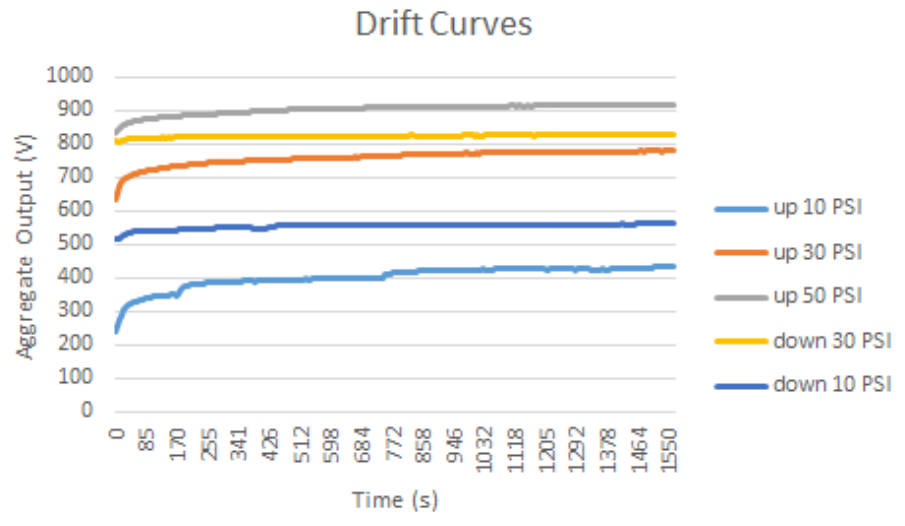
Figure 4. Drift of the Aggregate Output registered by the PCB based sensor for different increments and decrements of the uniform force on its